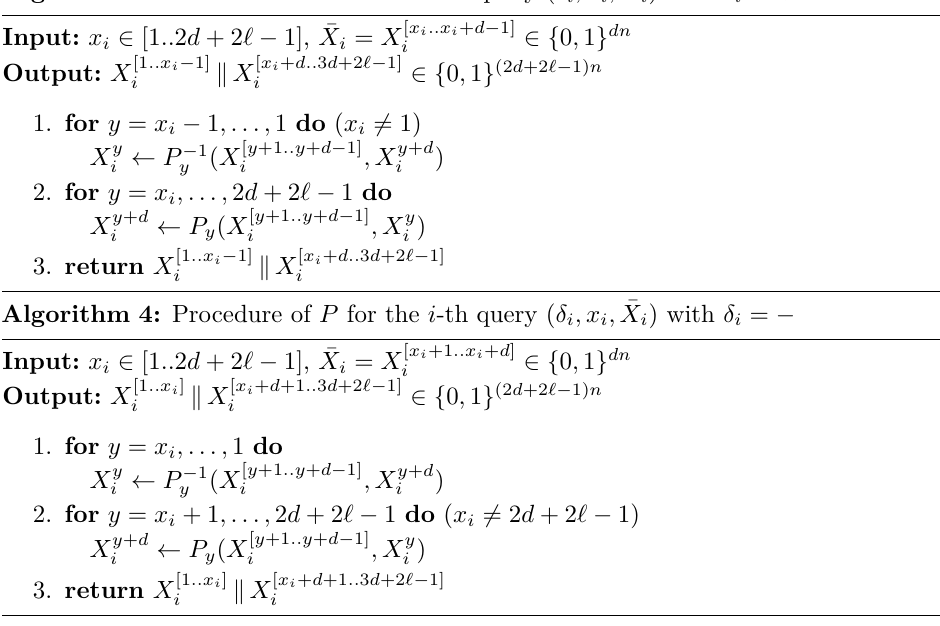
Algorithm 3: Procedure of P for the i -th query ( δ